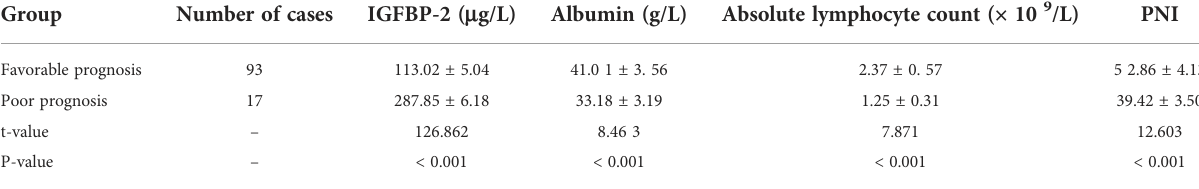
TABLE 5 Comparison of IGFBP-2, albumin, absolute lymphocyte and PNI values in patients with different prognoses in the observation group [x ̅ ± s]. Group